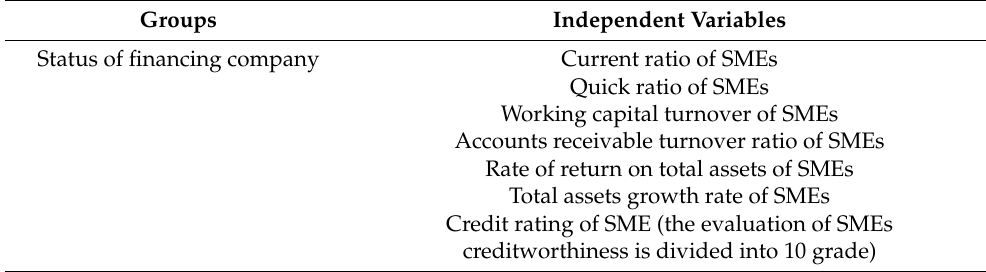
Table 2. Variables for enterprise credit risk